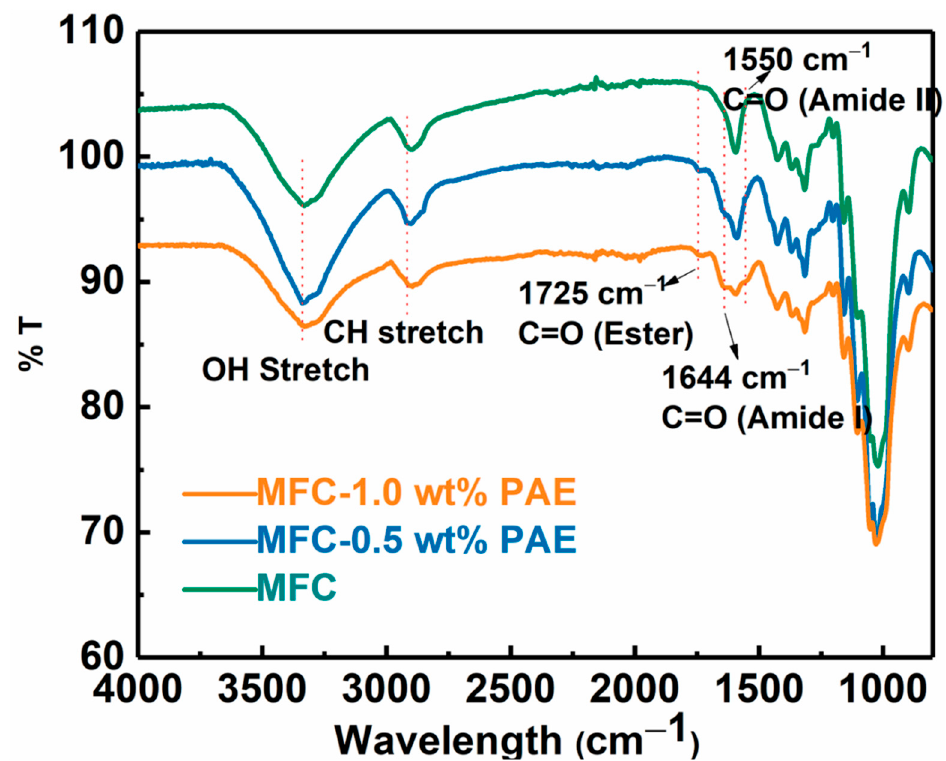
Figure 5. FTIR analysis of MFC and PAE cross-linked MFC membranes (with different PAE concentrations).